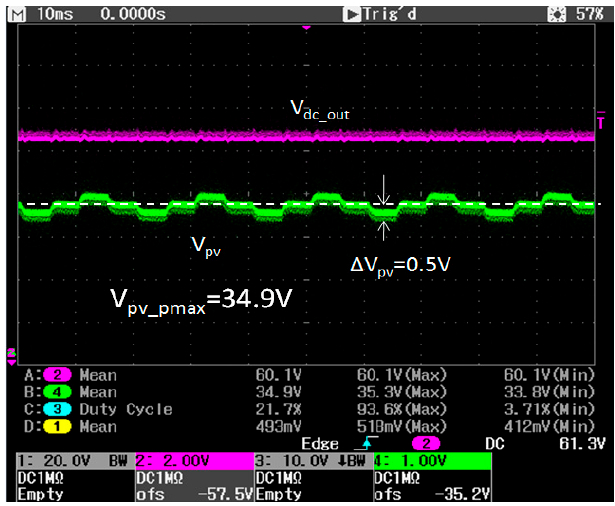
Figure 23. Measured terminal voltage of the constructed PV source for testing a boost dc/dc converter with P&O MPPT algorithm.